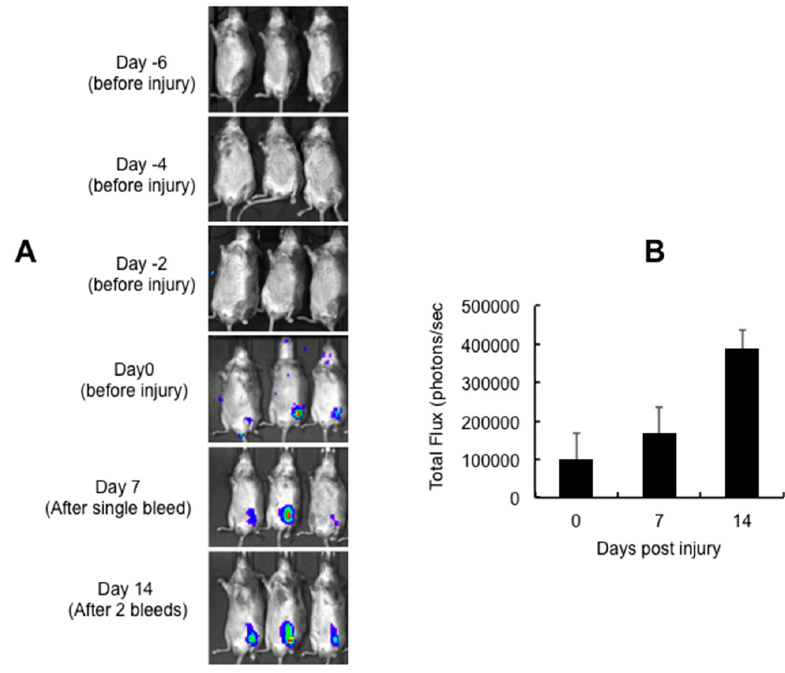
Figure 3. Persistence of intra-articular gene (luciferase) expression following multiple episodic bleeding. Approximately 5 × 10 9 vector particles (in a volume of 10 μ L) of AAV5-Luc was injected into the left knee of 10-week-old C57BL/6 mice, seven days before the first injury (Day 0): ( A ) intra-articular luciferase expression at different days post vector administration; and ( B ) quantitative data of transgene expression 0, 7 and 14 days post injury. Images for bioluminescence were captured in an IVIS Spect-CT small animal imaging system (Perkin Elmer, Caliper Life Sciences, Hopkinton, MA, USA).